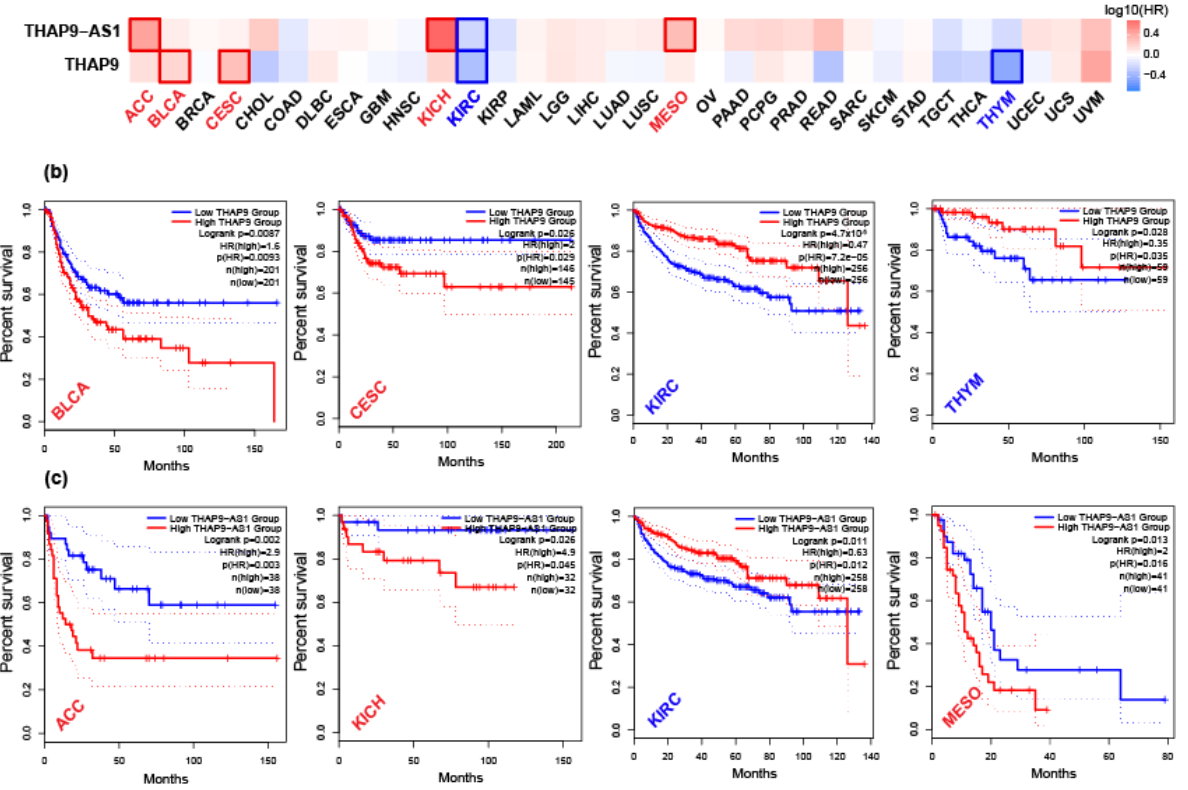
Figure 8. Disease-free survival analysis using GEPIA2. ( a ) The relationship between THAP9 and THAP9-AS1 gene expression and the disease-free survival prognosis of cancers in TCGA. The median was selected as a threshold for separating high-expression and low-expression cohorts. The red and blue blocks represent higher and lower risks, respectively, with an increase in the gene expression. The bounding boxes depict the significant ( p < 0.05) unfavorable and favorable results,